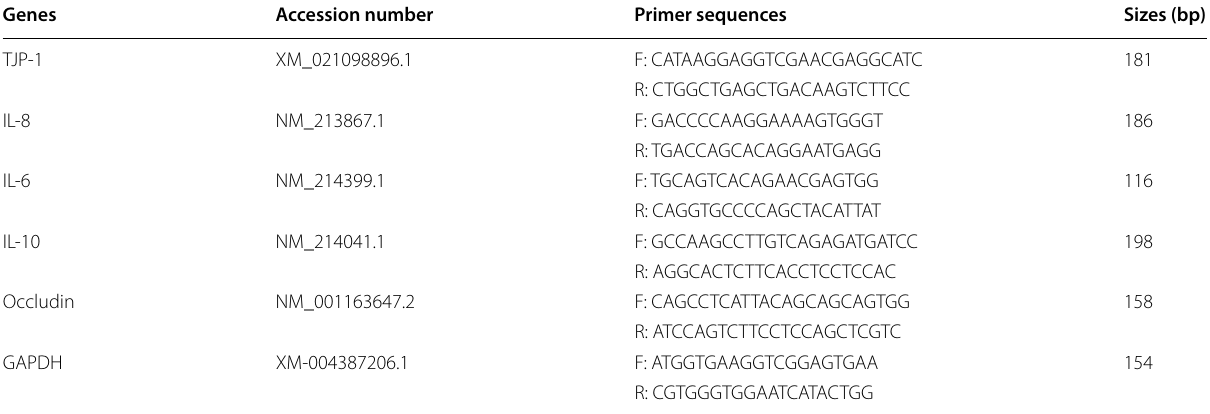
Table 1 Primer sequences of some genes for RT-PCR Genes Accession number Primer sequences